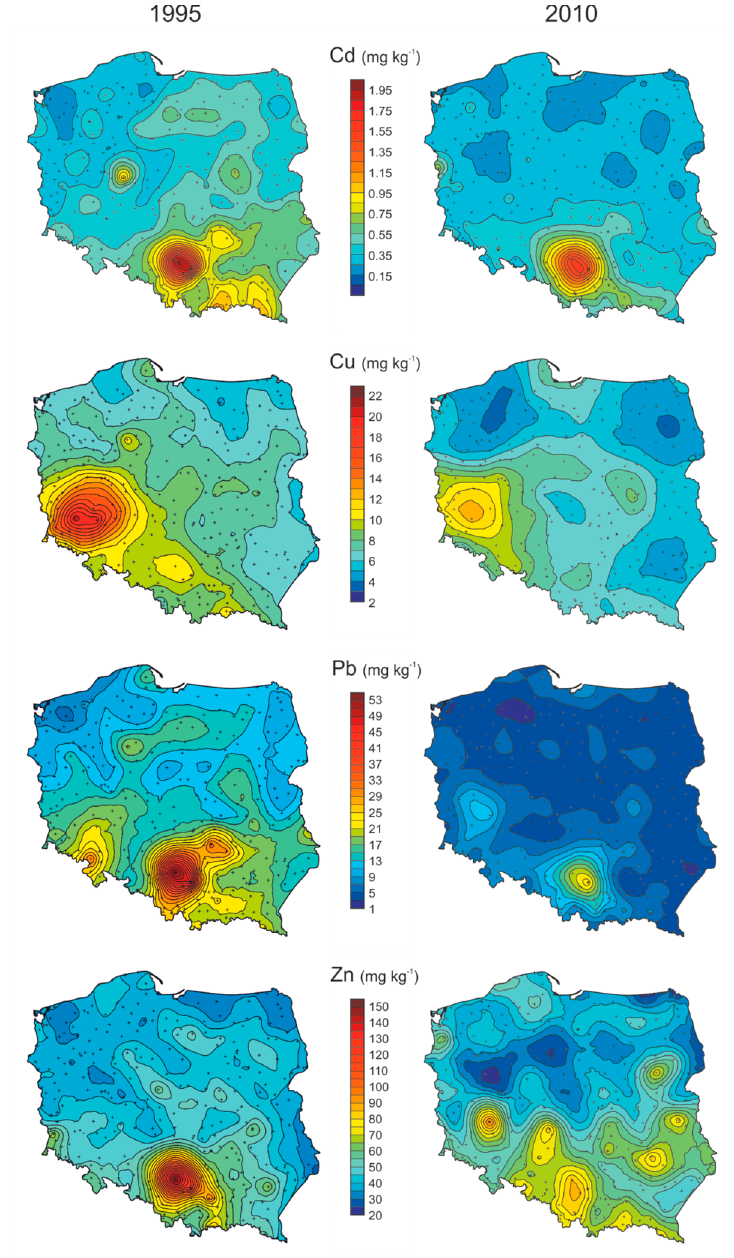
Figure 2. Spatial pattern of heavy metals distribution in Poland, based on the concentration of cadmium, copper, lead and zinc in Pleurozium schreberi (adapted from [38]).